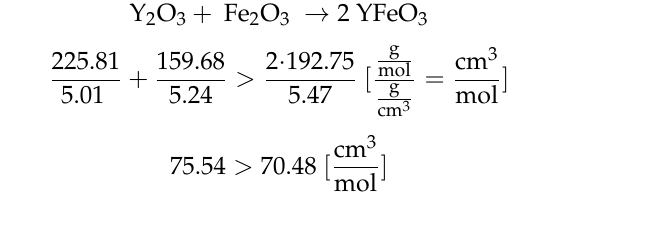
Figure 2. X-ray diffraction pattern of the powders: ( A )—Method A; ( B )—Method